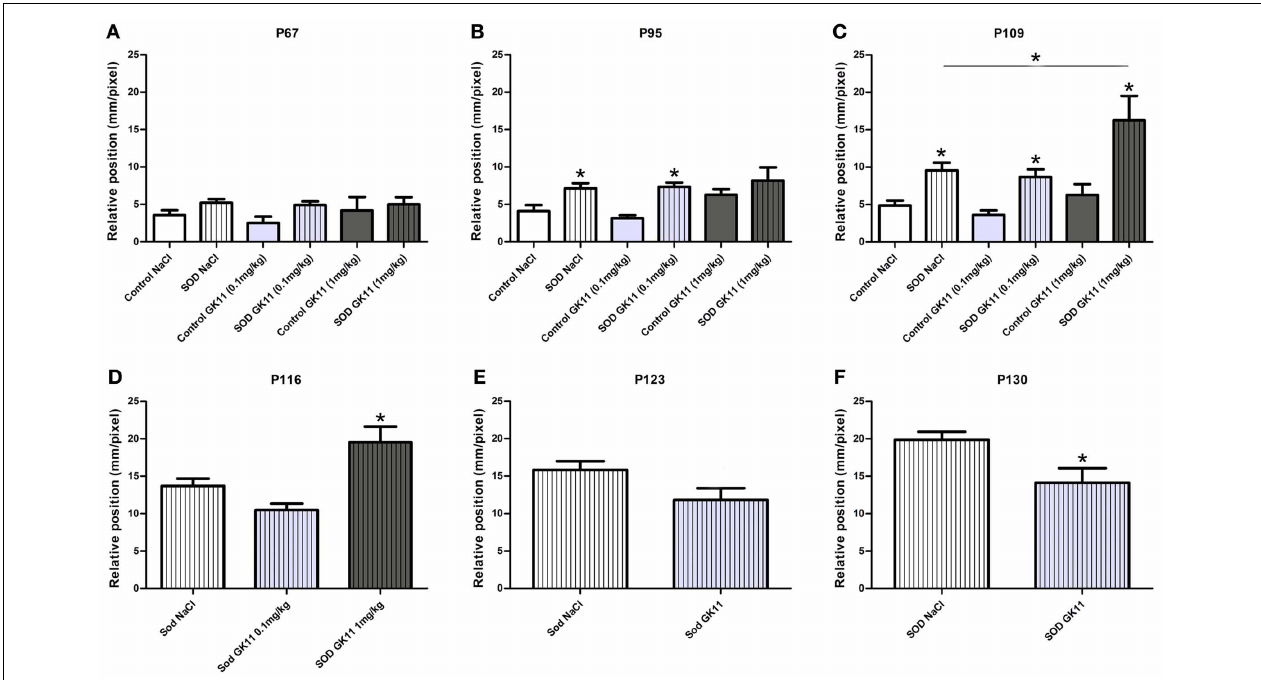
minimum of 4 and up to 24 animals per time point were analyzed from 67 to 116 days of age; recording were stopped for GK 11 1mg/kg after P116 due to hindlimb paralysis. Then due to progression of the paralysis a minimum of 8 and up to 15 animals per time point were analyzed from 123 to 130 days of age. Statistics: ( A–C ): two ways ANOVA followed by Tukey Kramer test. D : one way ANOVA followed by Tukey Kramer test. ( E , F ): one way ANOVA followed by Mann-Whitney test. ∗ p < 0 .